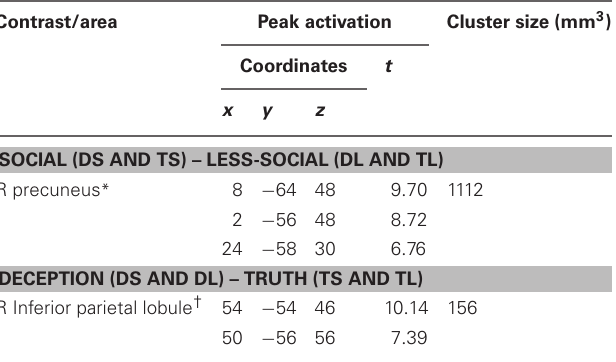
Table 2 | Cortical areas activated as the main effect under social and deception conditions.